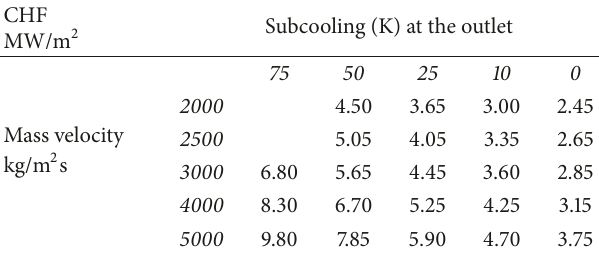
Table5:ExperimentalconditionsretainedforDNBtestsinan8 mm